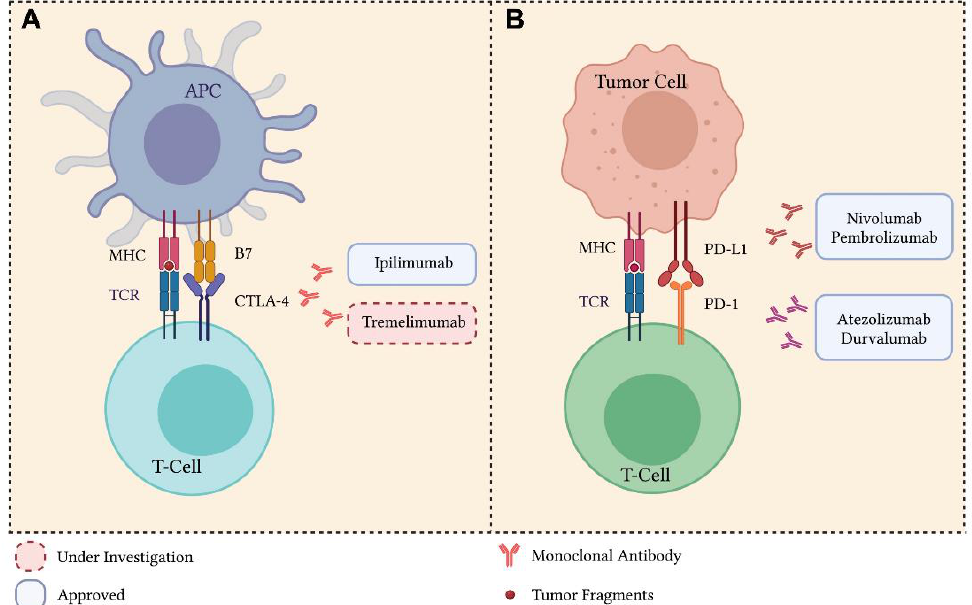
Figure 2. Immune checkpoint inhibitors for the treatment of lung cancer. ( A ) Molecular targets of anti-CTLA-4 mAbs ipilimumab and tremelimumab. ( B ) Molecular targets of anti-PD-1 and anti-PD- L1 mAbs nivolumab and pembrolizumab (anti-PD-1), atezolizumab, and durvalumab (anti-PD-L1). Blue boxes indicate FDA-approved drugs, and red dotted boxes indicate drugs under investigation.